Question: What does this figure show? Answer in one sentence.
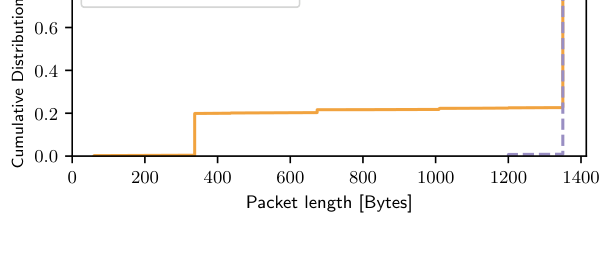
Answer: Size distribution of server’s packets of a 500 KB download.